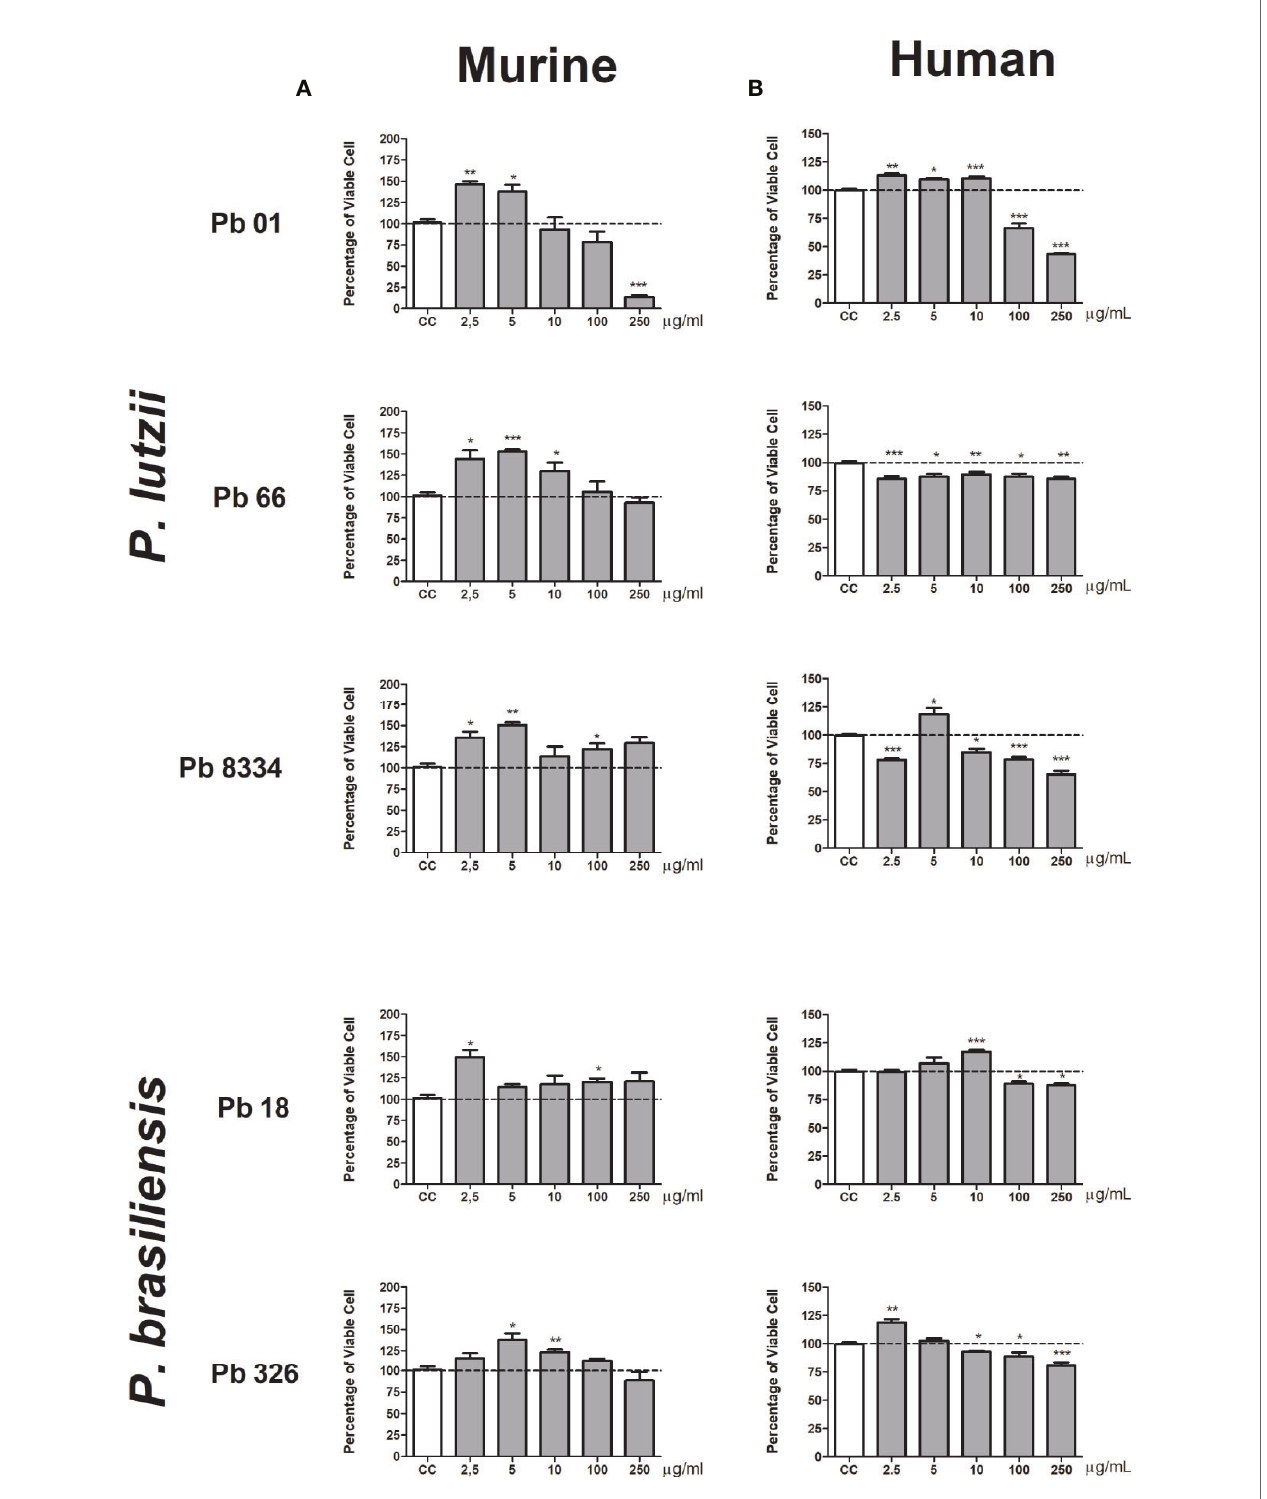
FIGURE 1 | Percentage of viable pulmonary fi broblasts stimulated with Paracoccidioides spp. exoantigens. Fibroblasts were cultured in the presence or absence of Paracoccidioides spp. exoantigens and evaluated 24 h post-treatment using MTT assays. (A) Murine pulmonary fi broblasts. (B) Human pulmonary fi broblasts. Fibroblast proliferation was measured according to the ratio of test culture cells (challenged with exoantigens) to untreated culture control (CC) cells. Values above 100% of viability represent cell proliferation. Results are expressed as mean ± SEM; paired t-test, * p < 0.05, ** p < 0.01, *** p < 0.001; n =